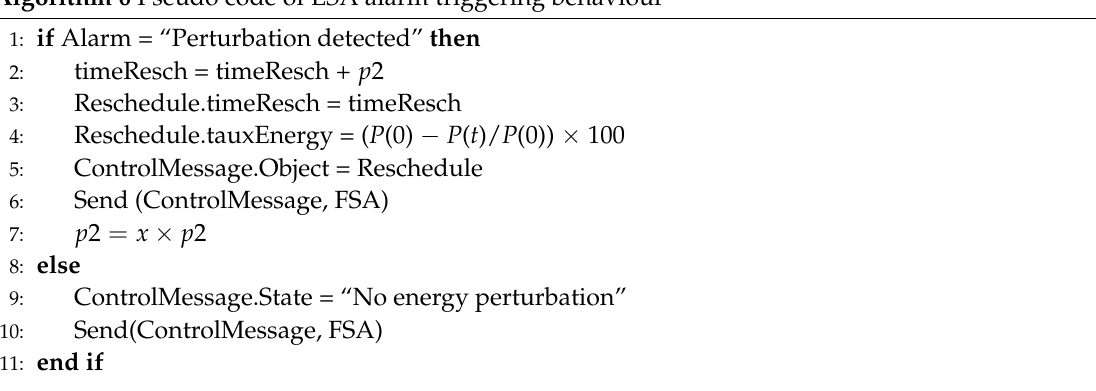
Algorithm 6 Pseudo code of ESA alarm triggering